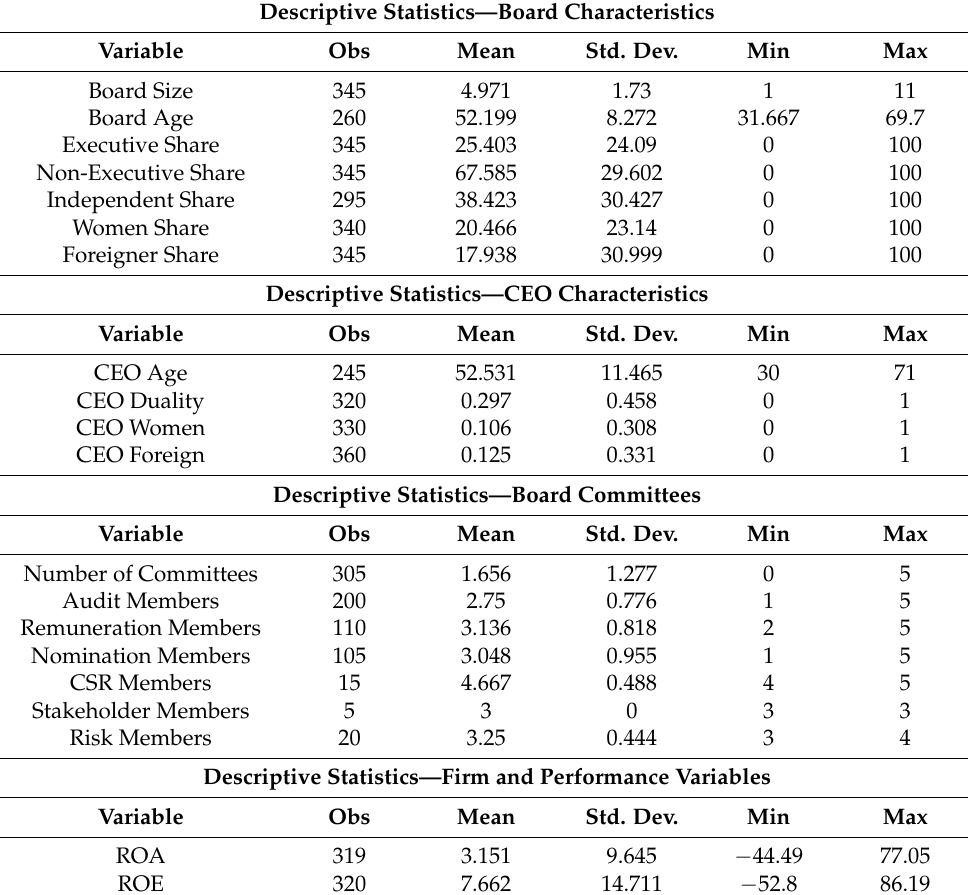
Table 2. Summary